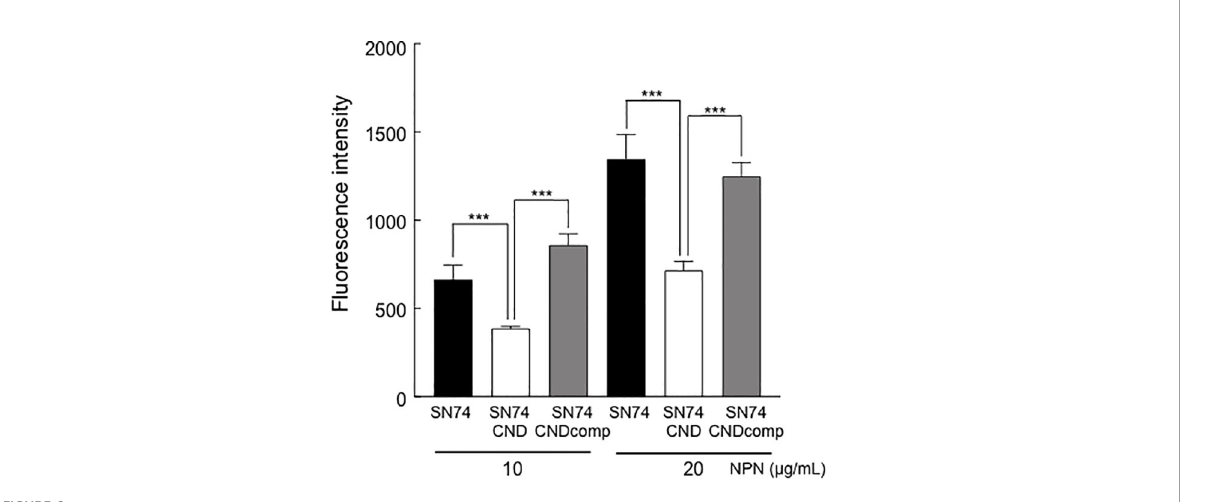
FIGURE 6 Analysis of exocytosis in strains SN74, SN74CND, and SN74CNDcomp. Fluorescence of the cells was examined in the presence of different concentrations of the fl uorescent probe N -phenyl-2-naphtylamine. Data are presented as the mean ± SD from fi ve independent experiments.